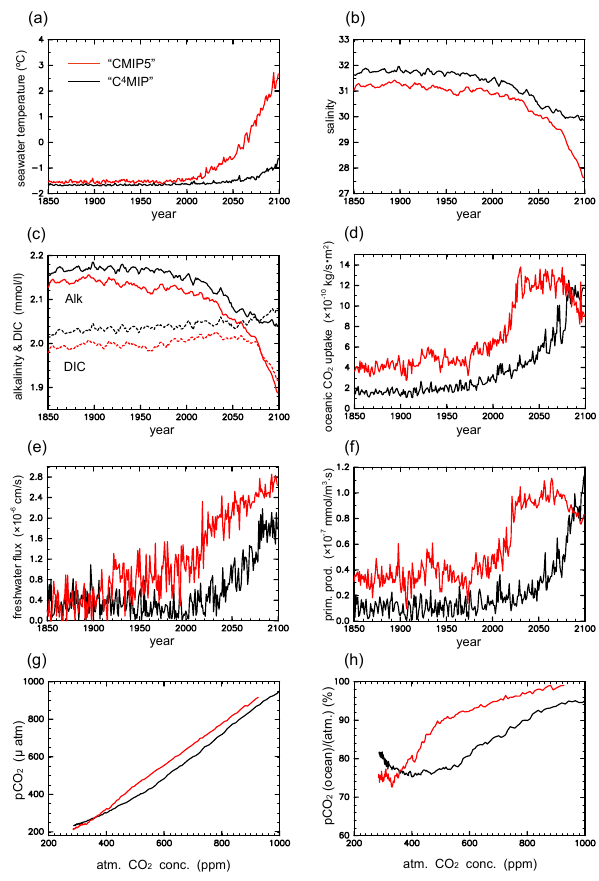
Fig. 4. Calculated annual mean, (a) seawater temperature, (b) salin- ity, (c) alkalinity and DIC, (d) oceanic CO 2 uptake, (e) freshwater input, (f) primary production, (g) seawater p CO 2 , and (h) fraction of p CO 2 between ocean and atmosphere at the Arctic surface for “C 4 MIP” (black) and “CMIP5” (red) model versions. These results are not drift-